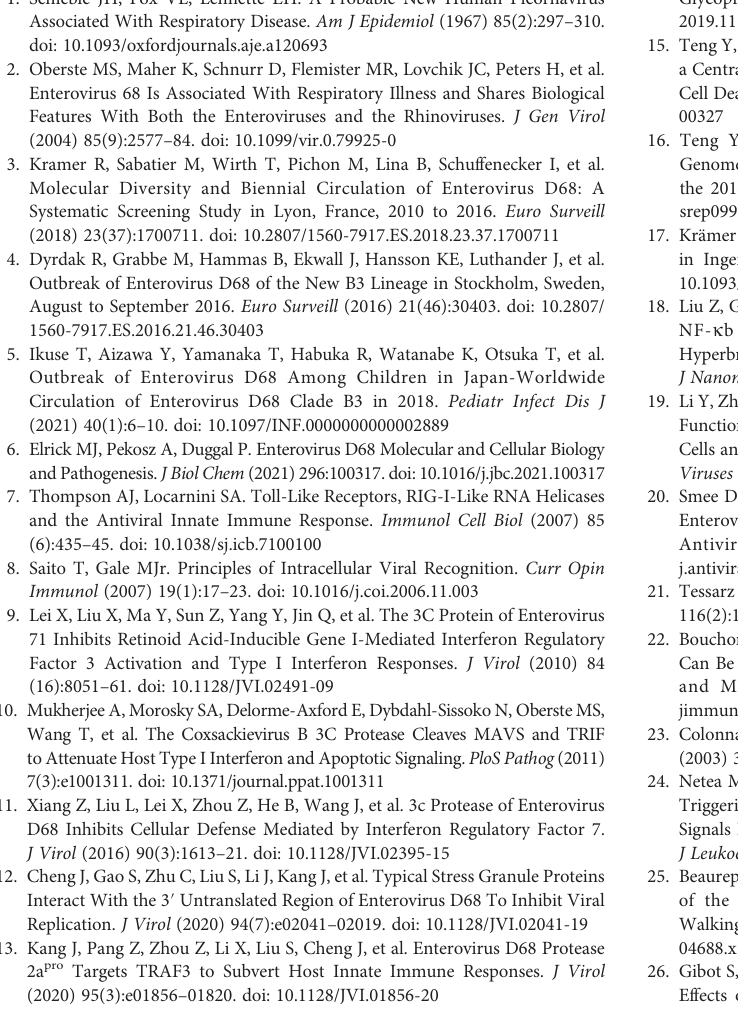
Supplementary Figure 1 | GO enrichment analysis of upregulated genes in mock vs. 6 hpi (A) , mock vs. 12 hpi (B) , and mock vs. 24 hpi [ (C) groups]. The dot diameter represents the number of DEGs; color depth represents signi fi cance; the abscissa represents the ratio ofthe numberof DEGs annotatedto GO terms to total DEGs; the ordinate represents different GO terms.